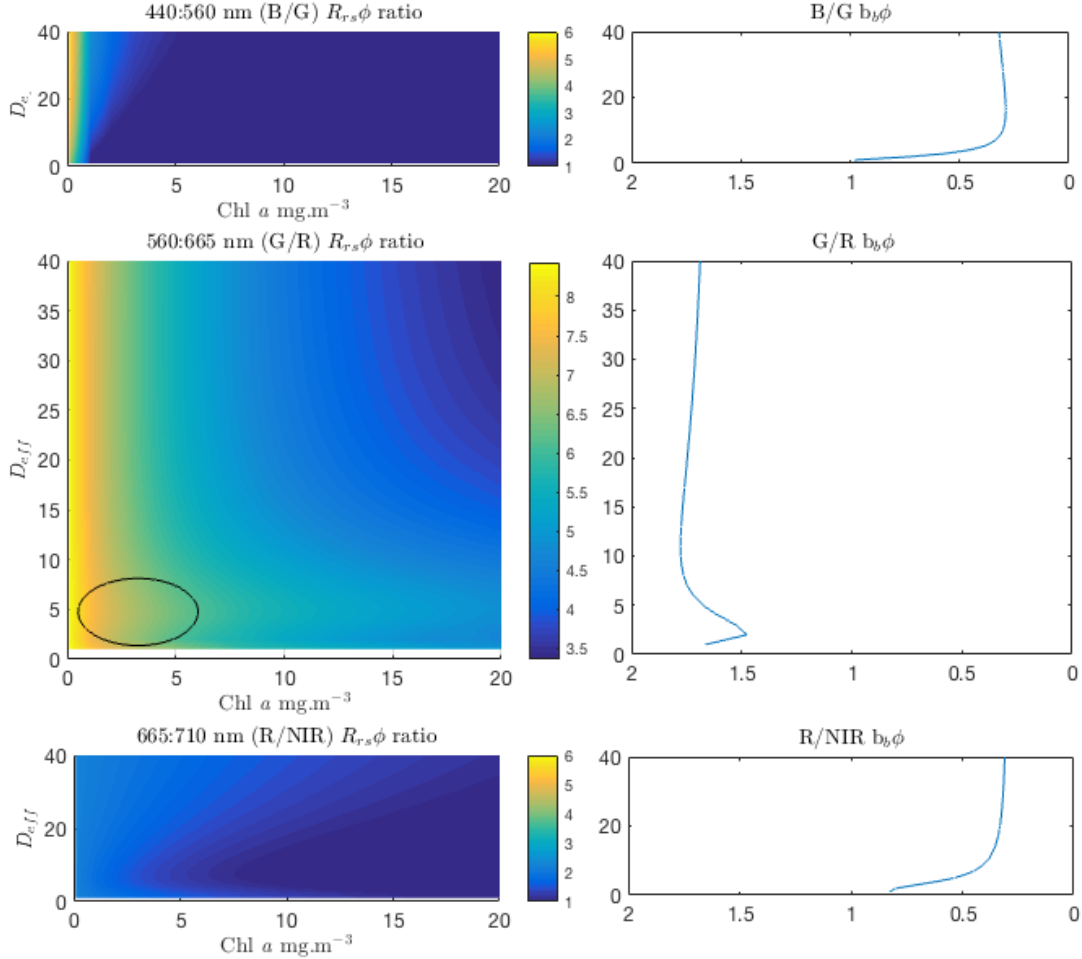
Figure 11. R rs φ ratios for blue:green, green:red and red:NIR (Near Infra-Red) wavelengths as shown, for Chl a concentrations of 0.1 to 20 mg/m 3 and D ef f 1 to 40 µ m. The B/G ratio shows a strong biomass dependency and a small sensitivity to size at large sizes, for 0.5 ≤ Chl a ≤ 4.5 mg/m 3 . The b b φ ratios